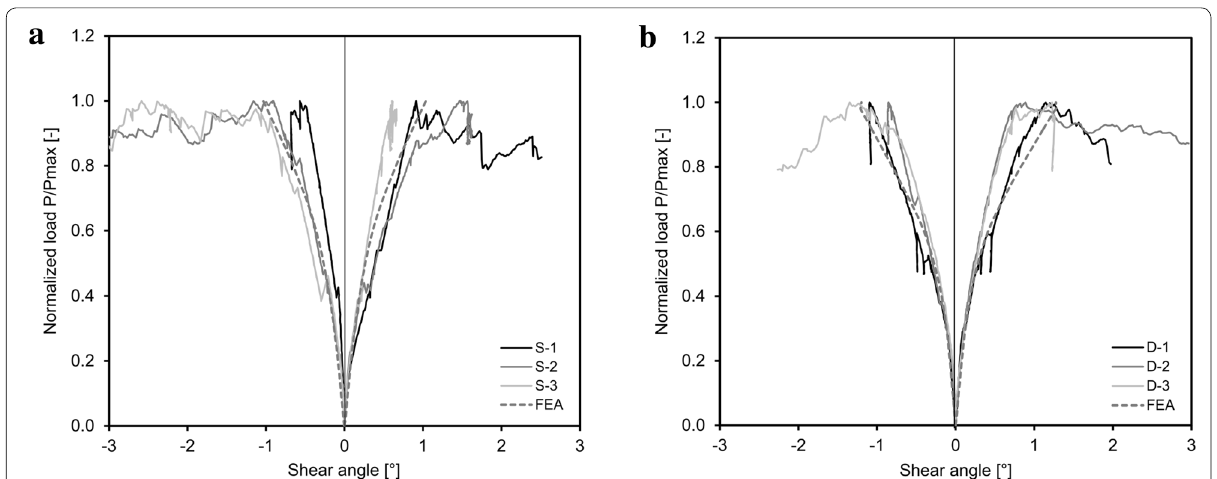
Fig. 14 Development of the shear angle at two beam ends for specimens compared to FEA results; a S-(1–3) and b D-(1–3).